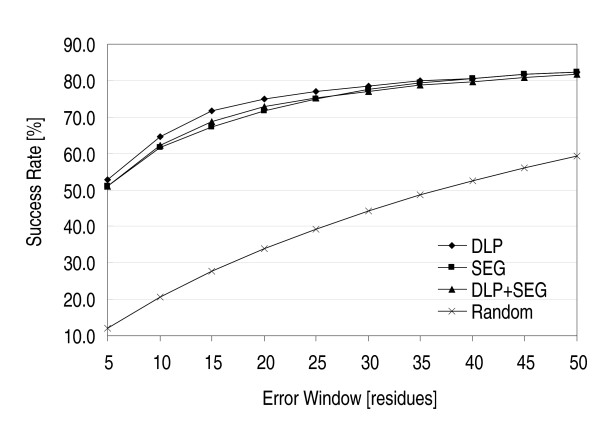
Comparison with blind prediction. The success rate (prediction quality index) of blind prediction is plotted as a function of the error window parameter (cross marks). The prediction quality factors for domain linkers (diamonds), low-complexity regions (squares), and a combined prediction (triangles) are also shown.